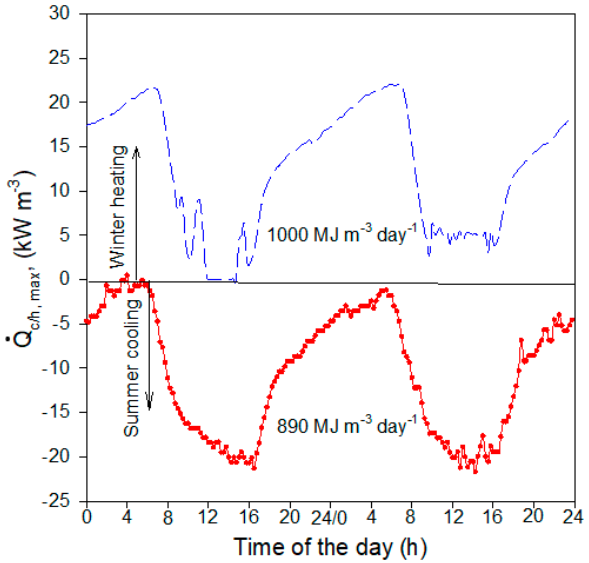
. Q c / h , max ) that an EAHE can